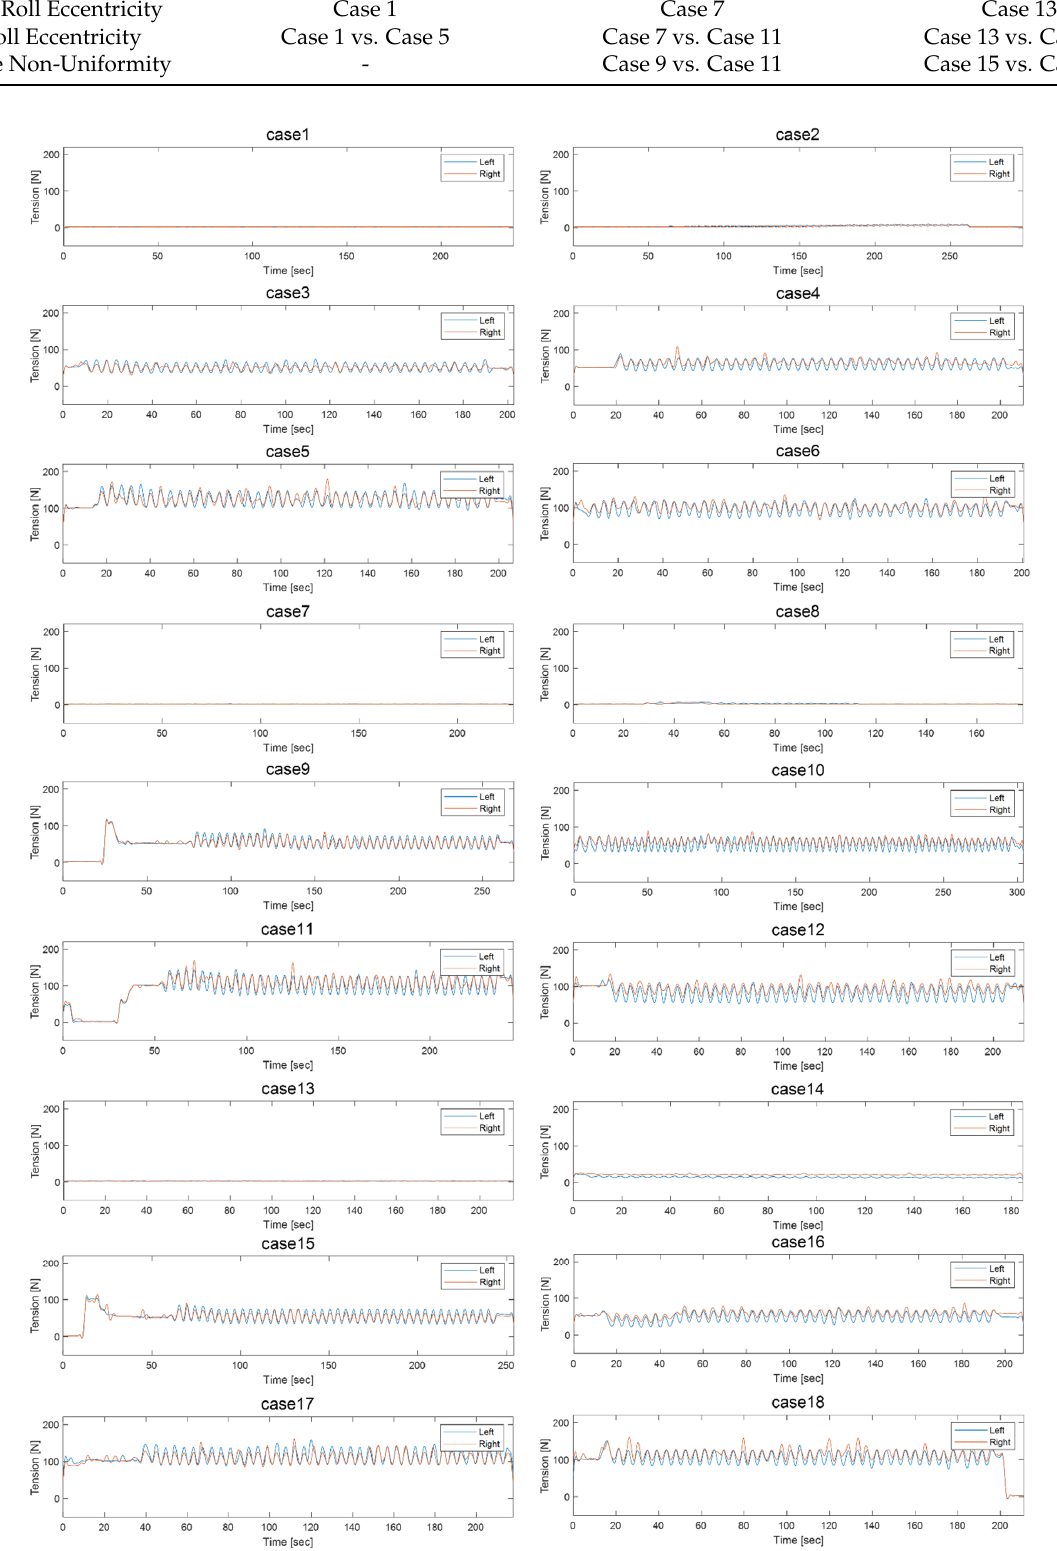
Figure 5. Nip force uniformity data of Cases 1–18.